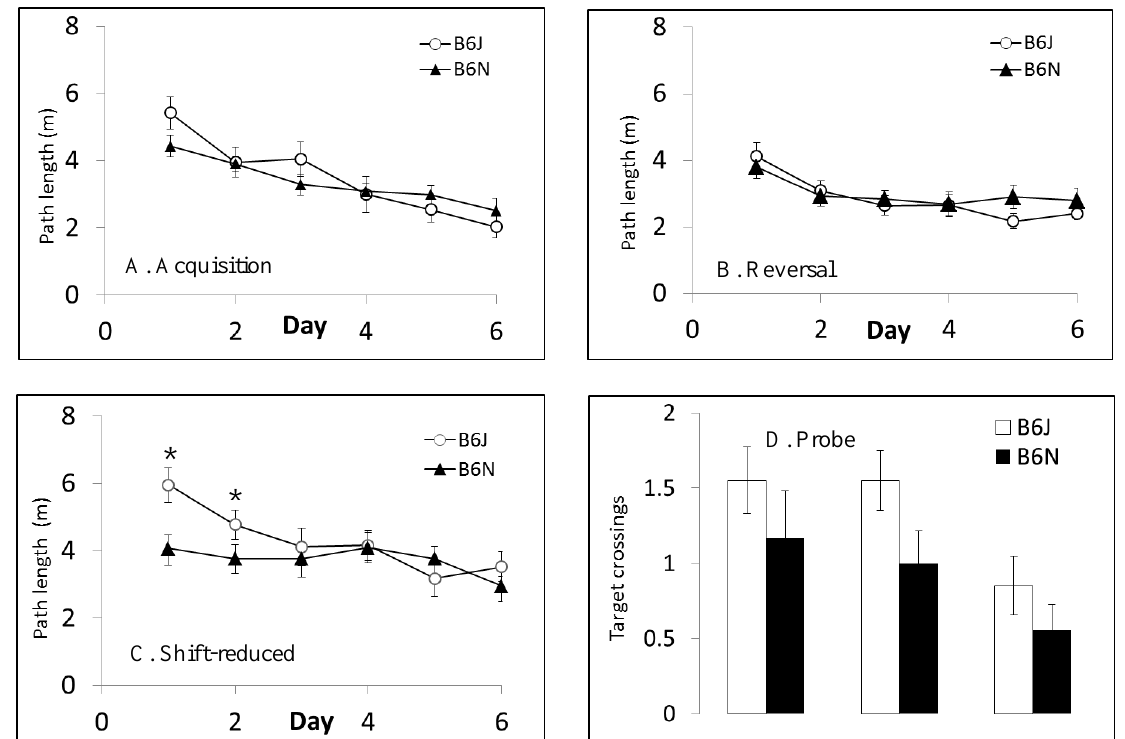
Figure 5. ( A – D ) Morris water maze path length: males. When analyzing path length, there were no significant differences in the acquisition or reversal phases, but a significant difference on Days 1–2 in the shift-reduced phase with shorter path lengths in B6N males. The number of target crossings during the probe trials was not significantly different for males in any of the three phases. * p < 0.5. Data are the least square means ± S.E.M. B6J females had shorter latencies on Day 1 of cued platform testing (Figure 6A) compared with B6N females, but there were no other significant differences in latency to find the platform on Days 2–6 in cued or in any of the three hidden platform phases (data not shown). There was a significant main effect of day in all four phases ( p < 0.001). When path lengths were compared, there were no significant difference during the acquisition phase (Figure 6B). However, B6N females had significantly shorter path lengths during the more challenging reversal and shift-reduced phases ( F 1,122 = 14.34; p < 0.001) (Figure 6C,D). B6N females had significantly more platform crossings in the acquisition probe trial ( F 1,38 = 16.21; p < 0.0001), but there were no significant differences in the probe trials for reversal and shift-reduced (data not shown). Swim speeds were similar in females, with B6J mice swimming faster than B6N females (Figure